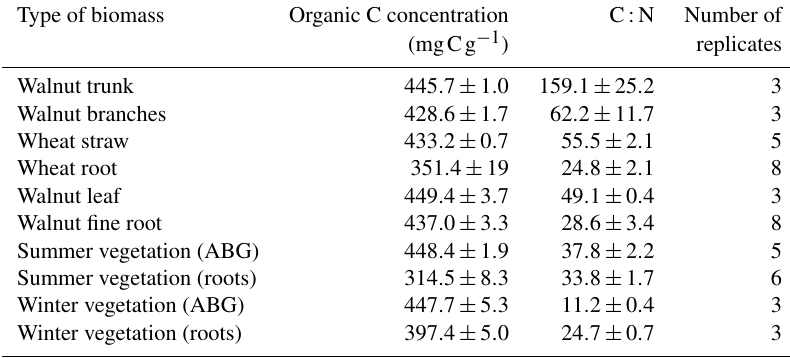
Table 2. Organic carbon concentrations and C:N ratio of the different types of biomass. Type of